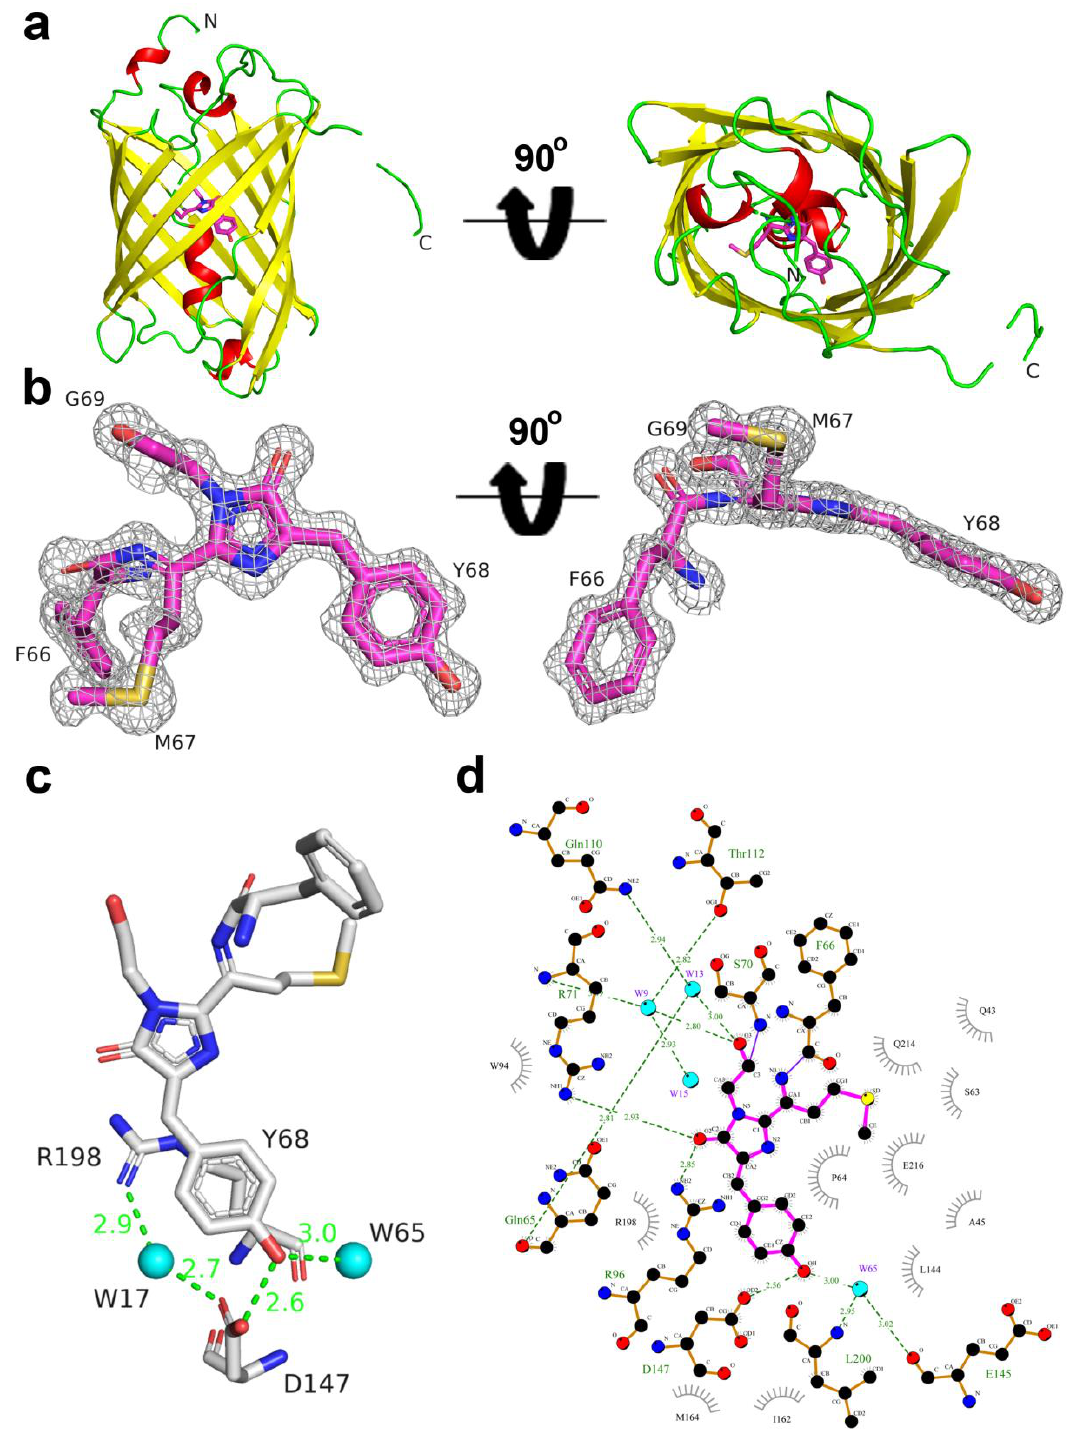
Figure 5. X-ray structure of the LSSmScarlet protein. ( a ) Cartoon representation of the overall LSSmScarlet structure. Chromophore, β -sheets, α -helixes and disordered structures are shown in pink, yellow, red and green colors, respectively. The orientation of the panel on the right is rotated 90 ◦ around the horizontal axis with respect to that on the left. ( b ) The chromophore of the LSSmScarlet protein refined into the electron density map. The 2F 0 -F C electron density map for the LSSmScarlet chromophore structure (sticks in pink) is contoured at 1.5 σ level and shown as gray mesh. The orientation of the chromophore on the right is rotated 90 ◦ around the horizontal axis with respect to that on the left. ( c ) Hydrogen bond network around the phenolic hydroxyl group of the LSSmScarlet chromophore. ( d ) The immediate environment of the LSSmScarlet chromophore.